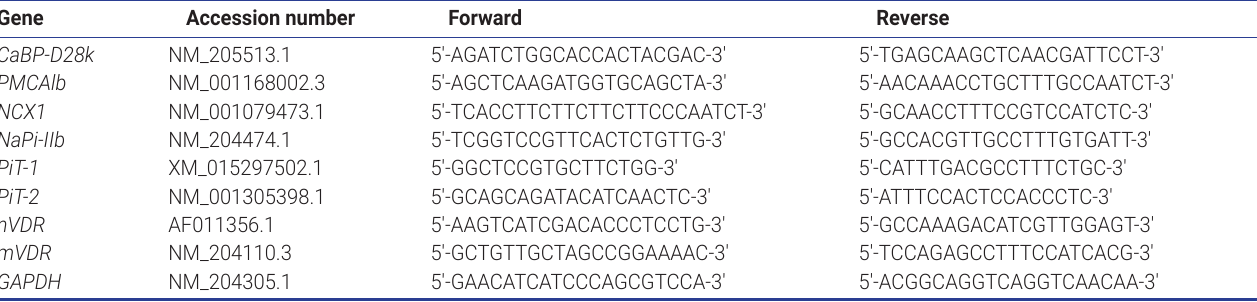
Table 2. Primer sequences used in real-time quantitative polymerase chain reaction